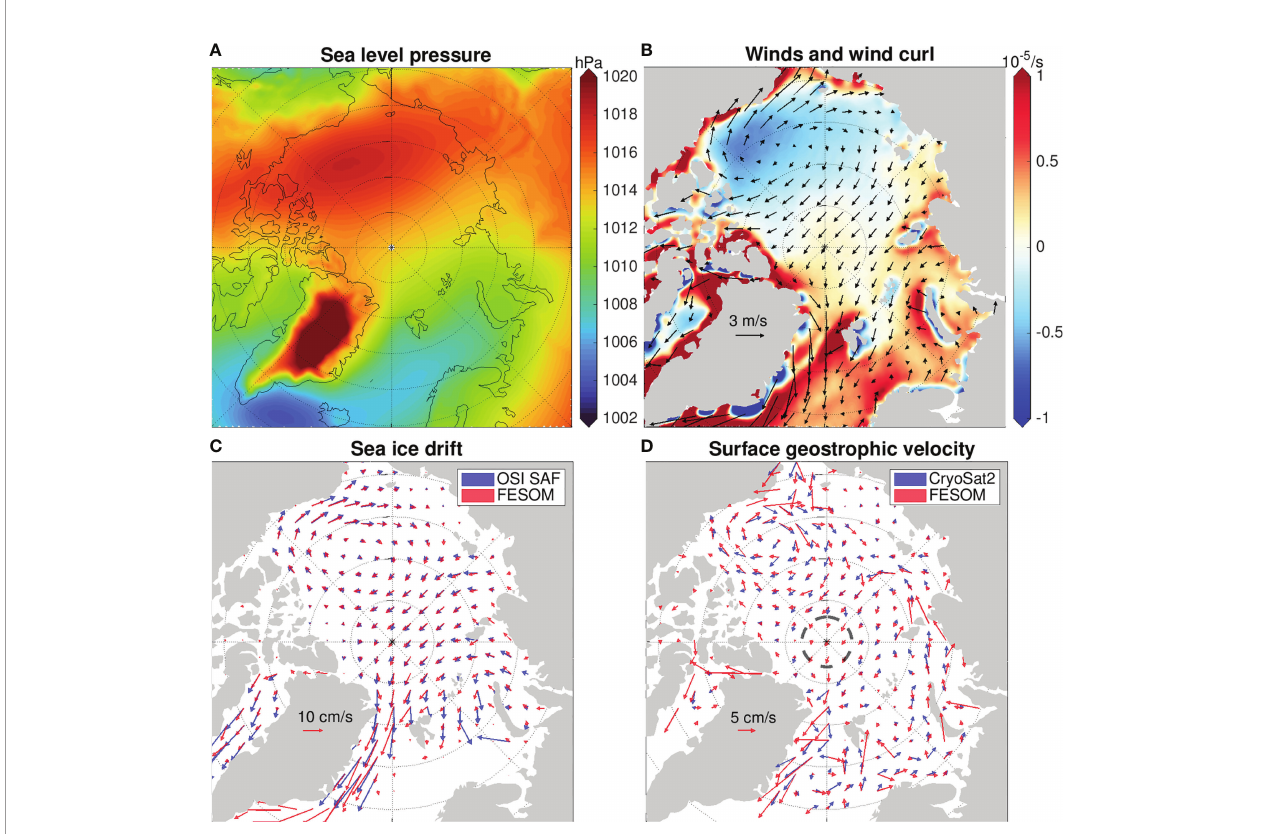
FIGURE 2 | Mean circulation of atmosphere, sea ice and upper ocean in the Arctic. (A) Annual mean sea level pressure (SLP). (B) Annual mean winds [vectors] and curl of winds [color]. The SLP and winds are taken from JRA55-do reanalysis (Tsujino et al., 2018) and averaged over the period 2000 – 2019. (C) Winter (October to April) sea ice drift for 2010 – 2019 from the OSI-SAF observation (Lavergne et al., 2010) and FESOM simulation. (D) Annual mean ocean surface geostrophic velocity for 2011 – 2019 estimated from the dynamic ocean topography observed by CryoSat2 (Armitage et al., 2016; Armitage et al., 2017) and simulated in FESOM. The dashed circle close to the North Pole indicates the area where the CryoSat2-derived dynamic ocean topography is not